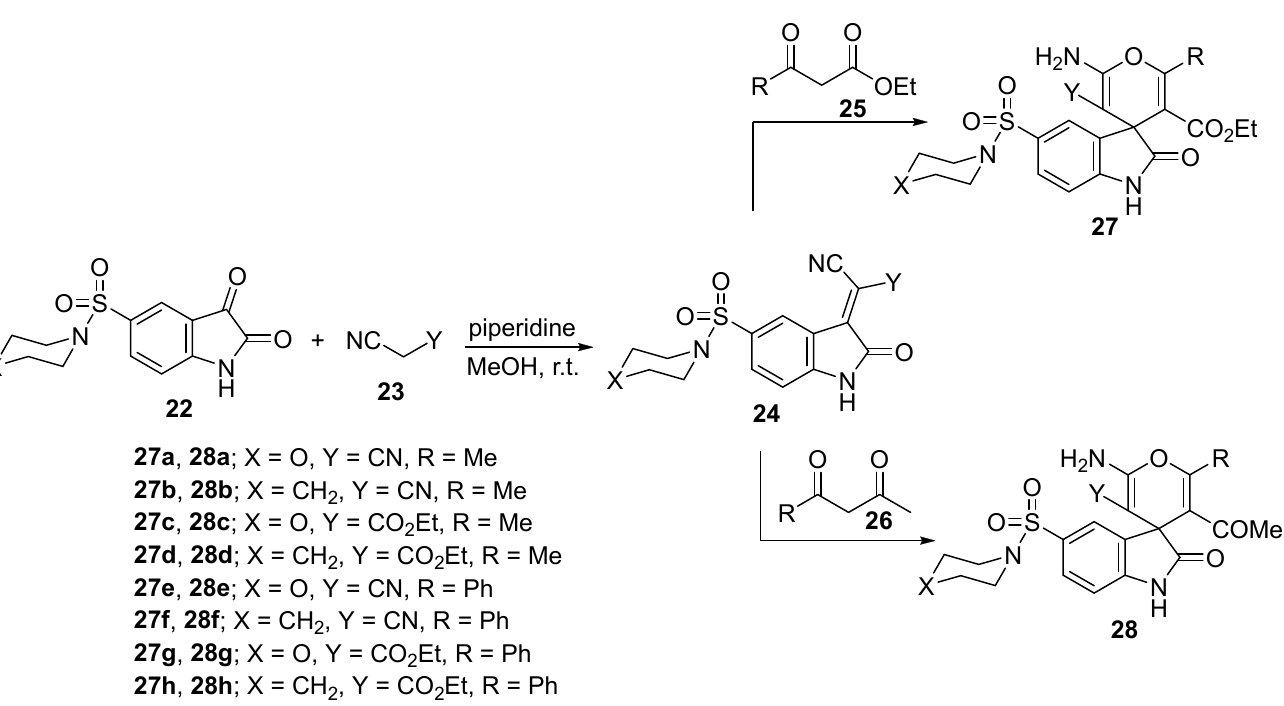
Scheme 2. Synthesis of spiro[indoline-3,4’-pyrans] 27 and 28